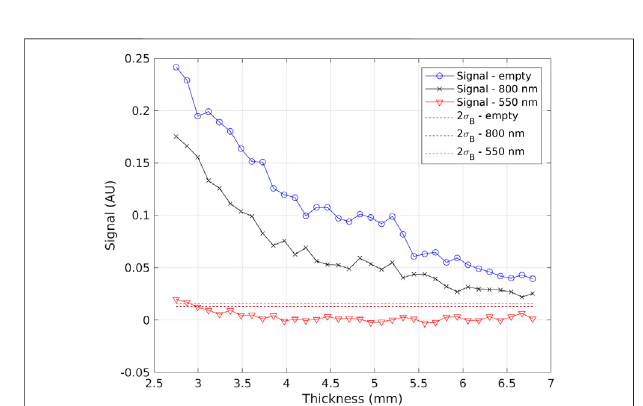
FIGURE 5 | Example graph used to determine the depth in liver corresponding to the 550-nm and 800-nm short-pass fi lters. The full- spectrum signal (blue), the 800 nm- fi ltered signal (black), and the 550 nm- fi ltered signal (red) are shown as a function of the depth in liver. The dashed lines represent twice the background noise, chosen as detection limit (black and red lines can ’ t be